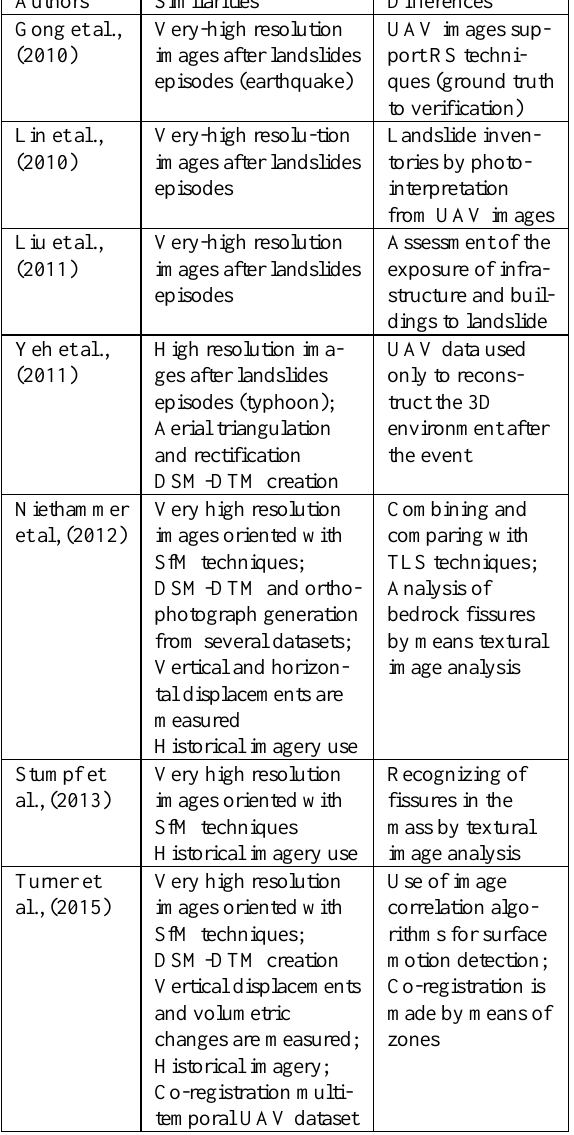
Table 3. Comparison of this study with similar other ones.